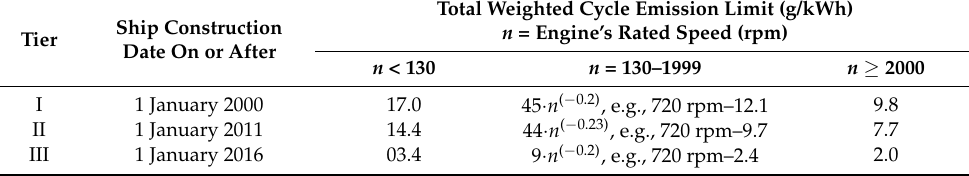
Table 1. The NO x limits according to MARPOL * Annex VI [7].